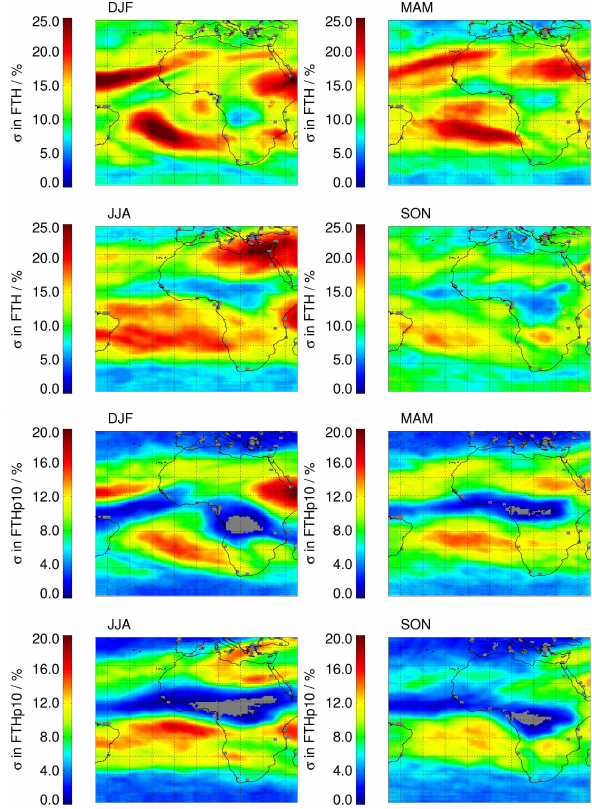
Figure 8. Relative standard deviation in FTH for each season (top four panels) and in FTHp10 (bottom four panels) over the period 1984–2009. Areas where only a small number of observations are valid are shown in grey.